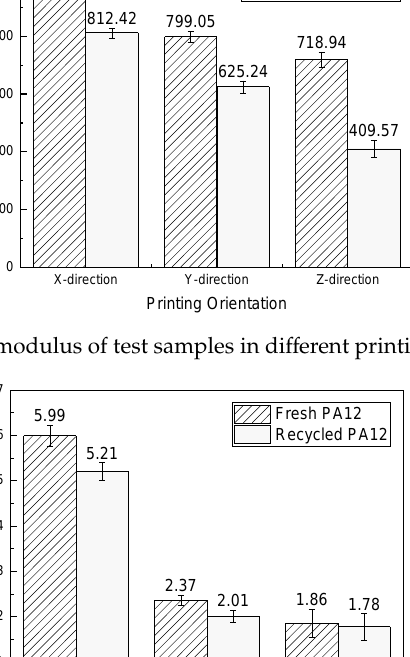
Figure 6. Impact strength of test samples in different printing orientations.